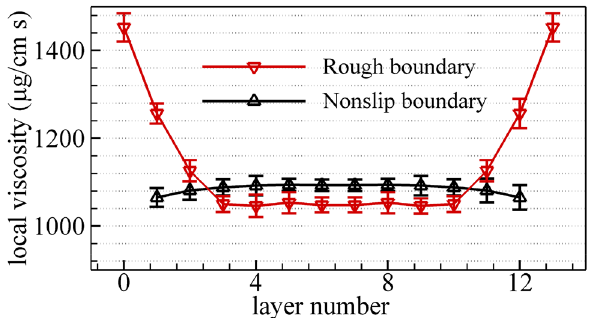
Figure 8. Comparison of the values of local shear viscosity of the nonslip boundary with that of the rough boundary. The viscosity values are calculated by fitting the local velocity information as obtained from the mixture boundary Poiseuille flow model ( T viscosity are also